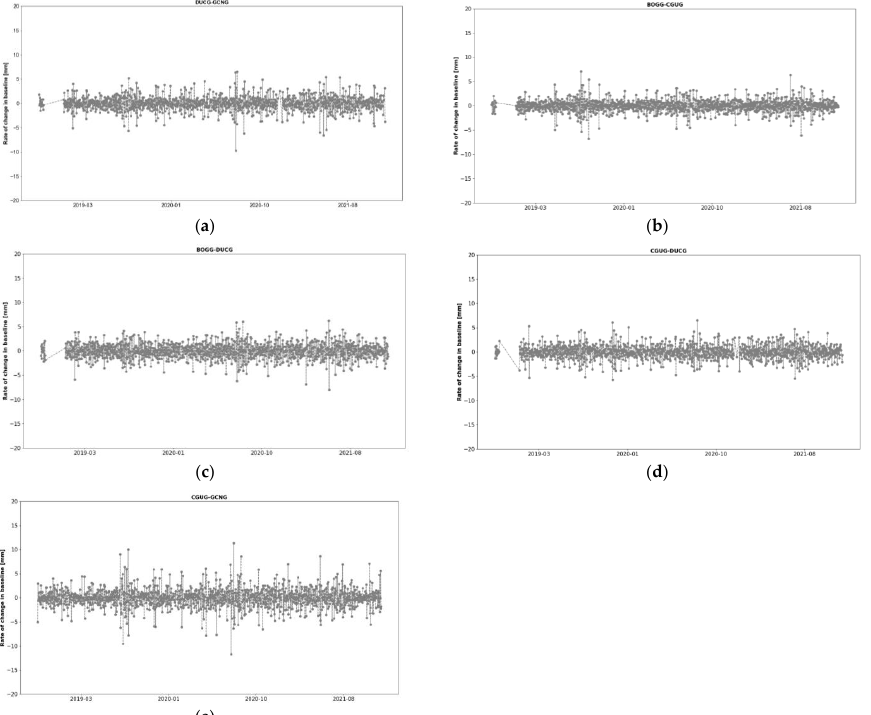
Figure 8. Rate of change in baseline ( a ) DUCG-GCNG, ( b ) BOGG-CGUG, ( c ) BOGG-DUCG, ( d ) CGUG-DUCG, ( e ) CGUG-GCNG.